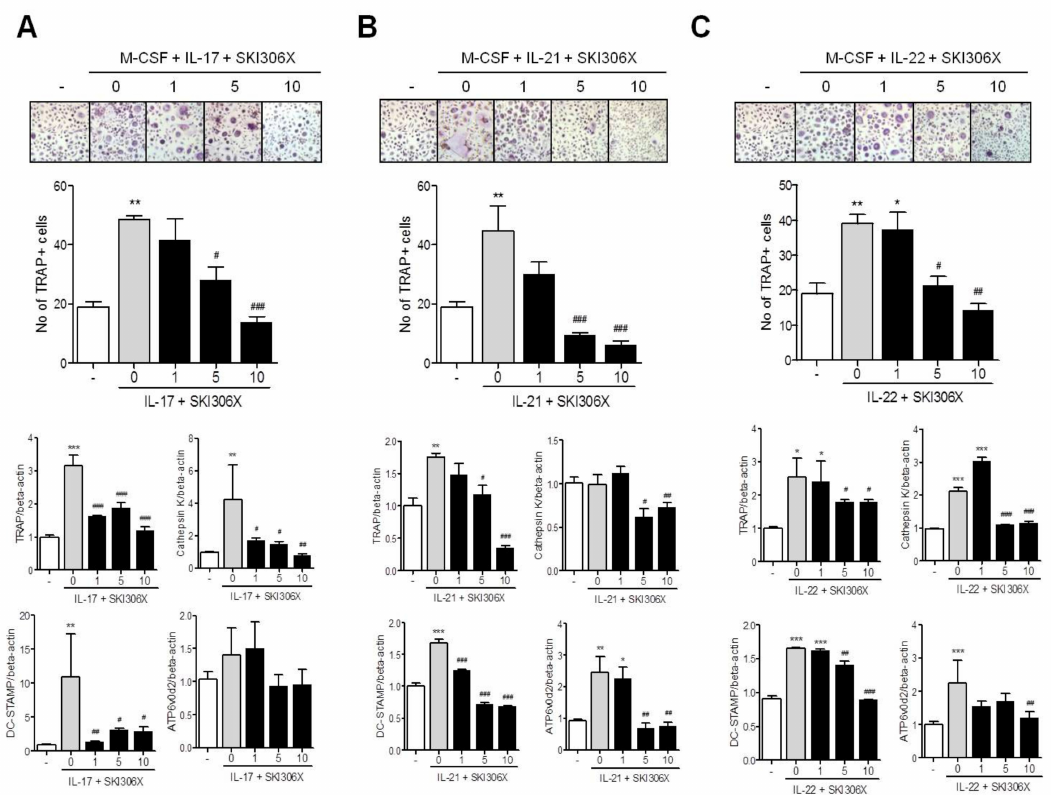
Figure 4. Regulatory e ff ect of SKI306X on Th17 cytokine-induced osteoclast di ff erentiation in peripheral blood (PB) monocytes. PB cluster of di ff erentiation (CD)14 + monocytes were cultured in medium supplemented with ( A ) IL-17, ( B ) IL-21, or ( C ) IL-22 and various concentrations of SKI306X in the presence of 25 ng / mL of monocyte colony stimulating factor. After 21 days of culturing, TRAP-positive multinucleated cells were enumerated. The figures represent one of three independent experiments and the bars represent mean ± SD values. The expression of osteoclast markers including tartrate-resistant acid phosphatase (TRAP), cathepsin K, dendritic cell specific transmembrane protein (DC-STAMP), and ATP6v0d2 was quantified using real-time PCR, normalized to beta-actin and reported in relative expression units. * p < 0.05, ** p < 0.01 and *** p < 0.001 compared with the nil condition (white bars). # p < 0.05, ## p < 0.01 and ### p < 0.001 compared with the Th17 cytokine stimulating condition (gray